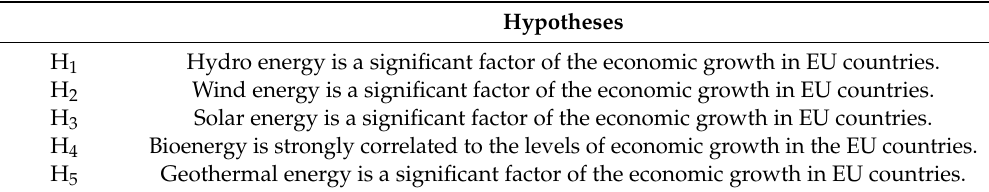
Table 1. Research